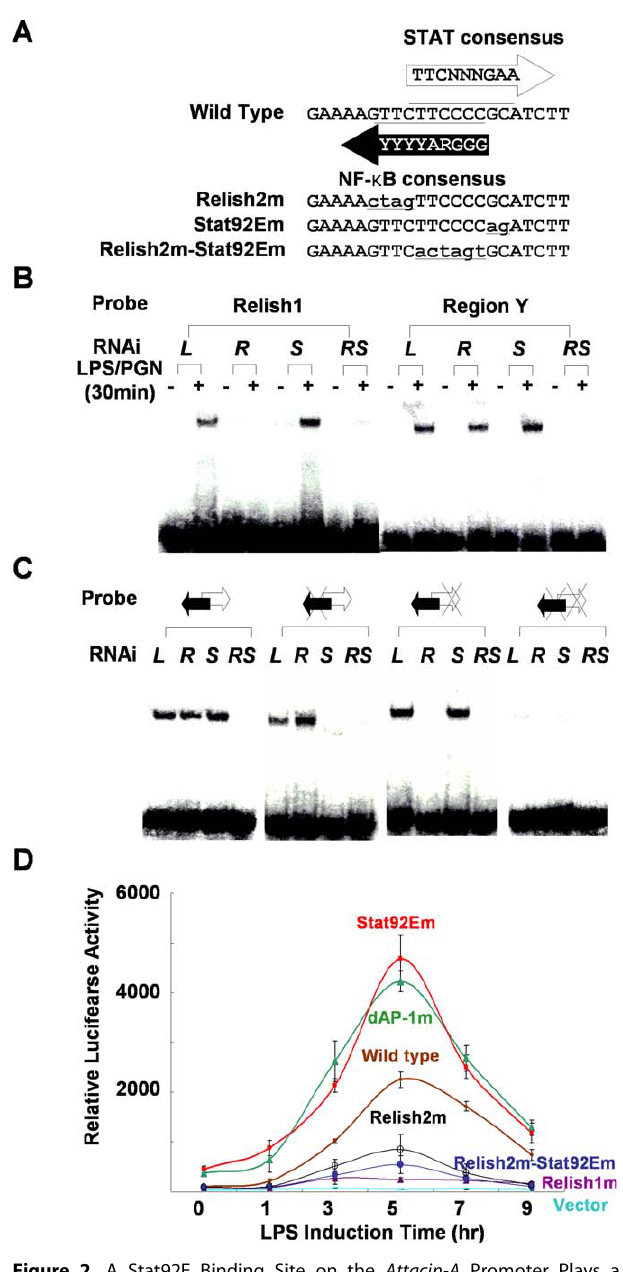
Figure 2. A Stat92E Binding Site on the Attacin-A Promoter Plays a Crucial Role in Down-Regulating Attacin-A (A) Region Y contains an NF- j B binding site and a STAT binding site. The NF- j B consensus and STAT consensus binding sequences are shown along with the wild-type sequence of region Y. The mutant forms of the NF- j B and/or the STAT binding sites of region Y are designated Relish2m, Stat92Em, and Relish2m-Stat92Em, respectively. The mutated sequences are shown in lower case and underlined. (B) Nuclear extracts of SL2 cells pre-incubated with dsRNA for Luciferase (L), Relish (R), Stat92E (S), or both Relish and Stat92E (RS) and treated with 10 l g/ml of LPS/PGN were assayed by EMSAs with 32 P-labeled double- stranded oligonucleotide probes containing Relish1 or region Y. (C) EMSAs with probes containing the wild-type region Y (double arrow), a mutation in the Relish binding site (double arrow with X on the left), a mutation in the Stat92E binding site (double arrow with X on the right) or mutations in both binding sites (double arrow with double X). Black and white arrows indicate the Relish 2 and Stat92E binding sites, respectively, and the mutations are indicated by Xs. Nuclear extracts were as in (B). (D) The dAP-1 and Stat92E promoter elements are required for